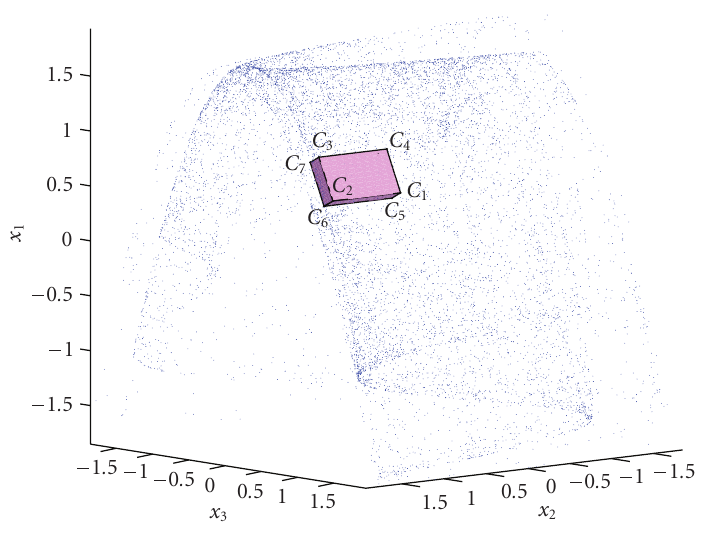
Figure 3.1. The attractor of the hyperchaotic generalized H´enon map.